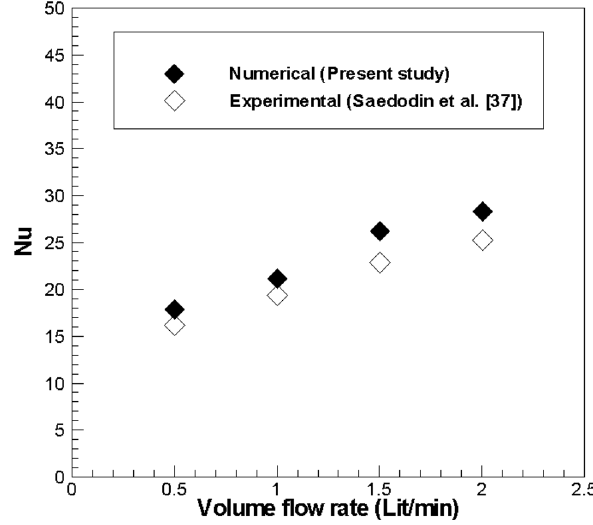
Fig. 4 The calculated Nu number vs experimental results of Saedo- din et al.